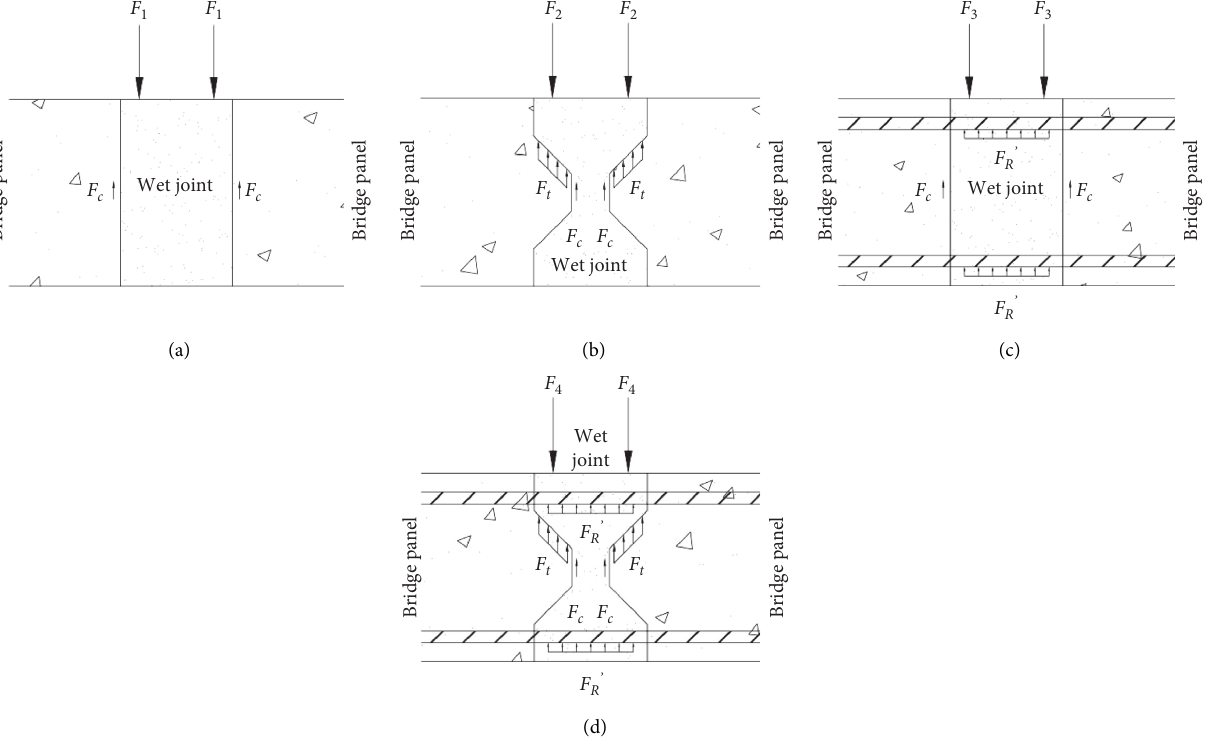
Figure 15: The load schemes of three specimens. (a) Wet joint with no shear key and reinforcement. (b) Loads on Type 1. (c) Loads on Type 2. (d) Loads on Type 3.